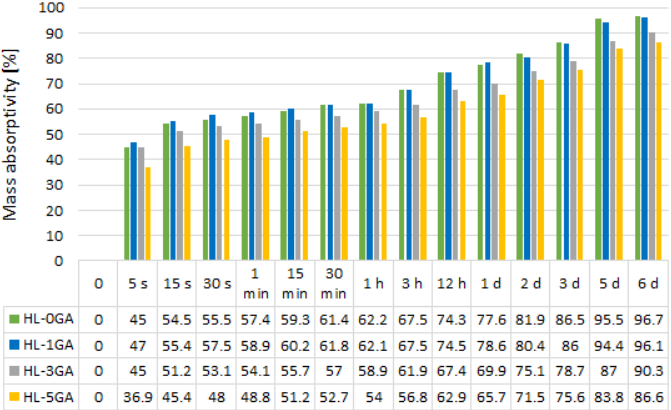
Figure 12. Average values of mass absorptivity of the tested composites.